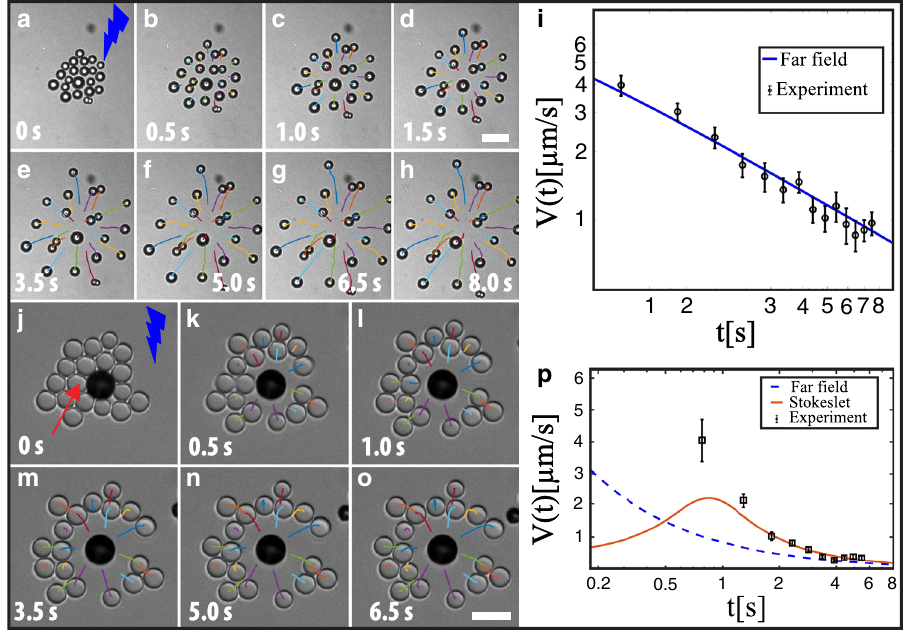
Fig. 3 Response of the isotropic TiO 2 particles under the illumination of UV light. a – h Time-lapsed bright fi eld micrographs show the pushing behaviour of individual swimmers against the neighbouring particles. These repulsions are isotropic. Overlaid trajectories reveal the dynamic response of the particles. i The average velocity over all particles decays with time as V ∝ t − 0.69±0.04 and follows the predicted far- fi eld scaling ( t − 0.67 ). The blue line is the prediction of the theoretical model obtained by numerical simulations. The error bars in i represent the standard deviation of the average velocity over all particles. j - o Dynamic response of the passive particles to an immobile active particle under the illumination of UV light. j – o Time-lapsed overlaid trajectories show the tracer passive particles experience isotropic repulsions and push the tracers radially. p An empirical fi t of the experimental velocity data shows the predictions of the theoretical model for the dynamics of tracer particles (solid line). The experimental average velocity over the all particles decays with time and follows the numerically obtained fl ow fi eld produced by an immobilised active particle, modelled as a near-wall Stokeslet. Broken blue line is the far- fi eld prediction which is expected to be valid at much longer times. The error bars in p represent the standard deviation of the average velocity over all particles. Scale bar is 5.0 μ